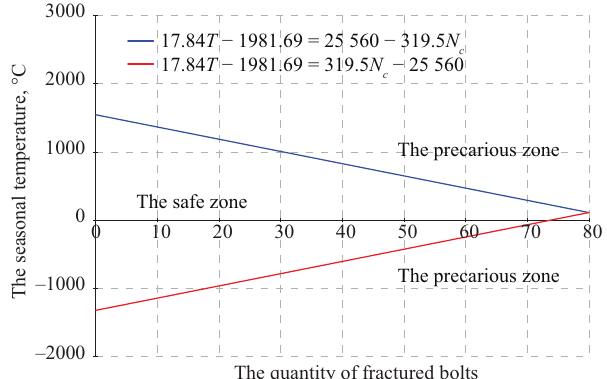
Figure 21. The relation between the seasonal temperature and the quantity of fractured bolts in the limit state